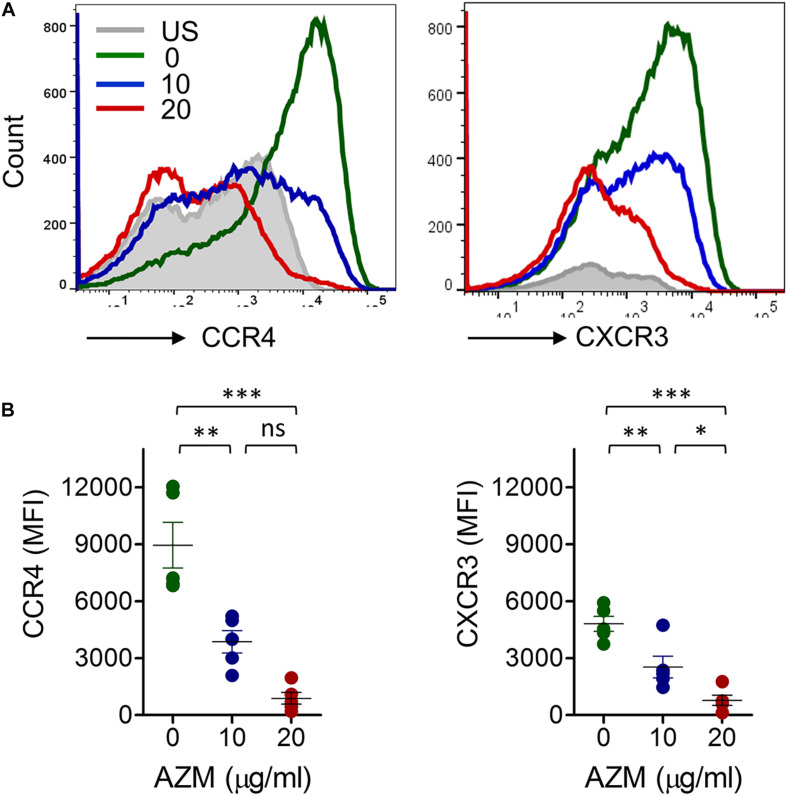
AZM downregulates CCR4 and CXCR3 expression on bulk CD4+ T cells. (A) Purified CD4+ T cells were stimulated with anti-CD3 and CD28 in presence of indicated concentration of AZM for 3 days. Cells were stained with anti-CCR4 and anti-CXCR3 monoclonal antibodies and looked for expression using flow cytometry. Representative FACS overlay histogram showing mean fluorescence intensities (MFI) of AZM treated and untreated cells. TCR unstimulated cells (US) serve as control. (B) Aligned dot plots show mean ± SEM of total CCR4+ and CXCR3+ cells on bulk CD4+ T cells. Data presented are from five independent experiments performed on healthy individuals (n = 5). *P < 0.05, **P < 0.01, ***P < 0.001, ns stands for non-significant.